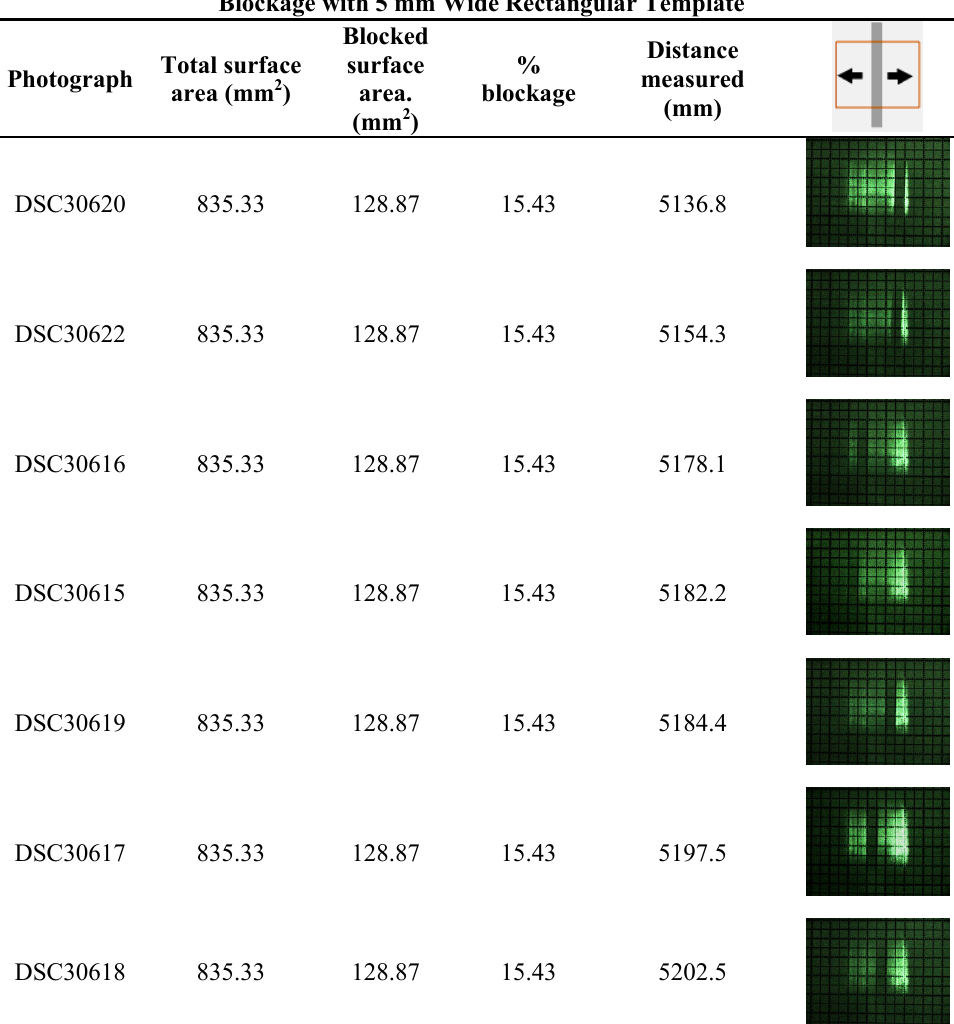
Table 2. Distance given by the LMS200 when different parts of the beam were blocked with the 5 mm wide rectangular template at a distance of 5 m from the sensor and when the unblocked part of the beam was captured by the grid template at a distance of 5.3